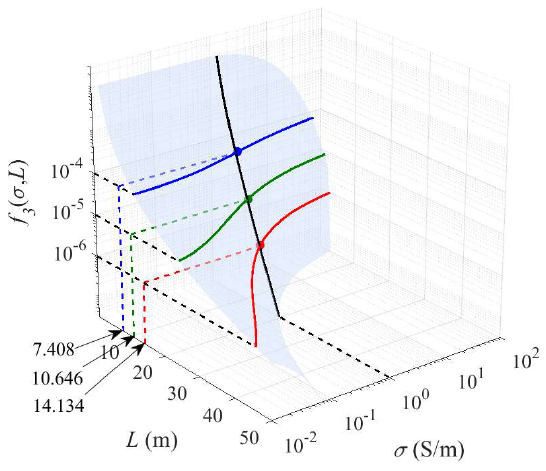
Figure 4. The graph of the function f 3 ( σ , L ) and the illustration of the process for choosing proper region size.